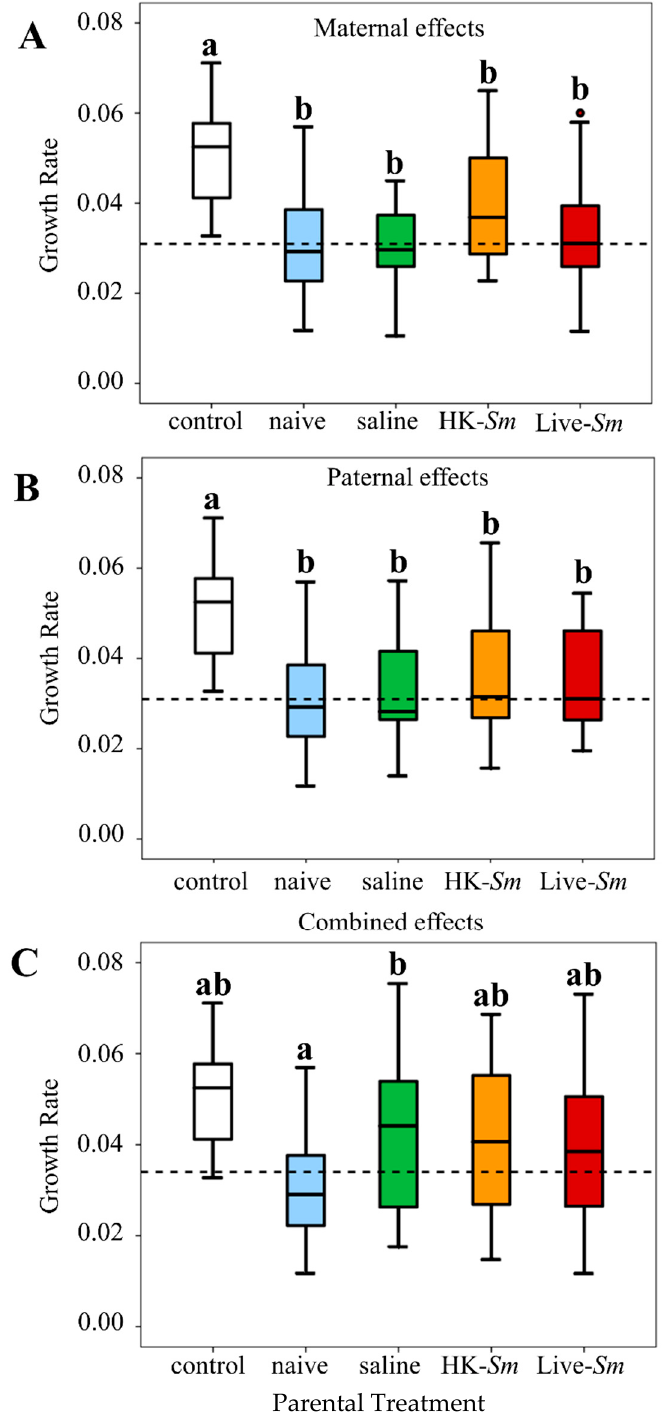
Figure 3. Median growth rates (GR) of Arthrobacter cultured with and without embryonic homogenates from ( A ) maternal effects, ( B ) paternal Effects, and ( C ) combined effects. Letters indicate statistical significance (Supplementary Table S3). Dashed lines indicate the median growth rate of Arthrobacter grown in the presence of embryo homogenates across the four parental treatments for each graph.